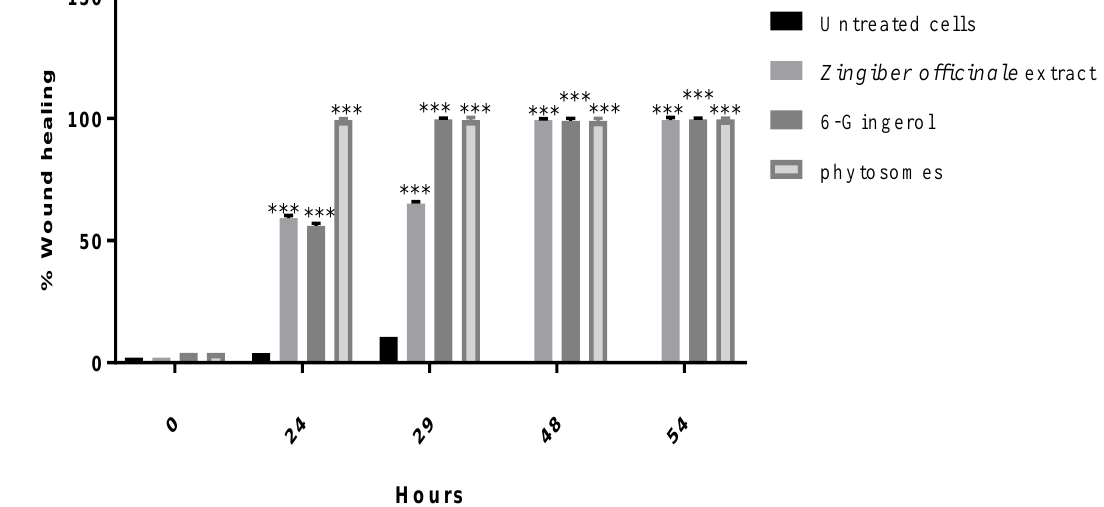
Figure 6. Effect of Zingiber officinale extract, 6-gingerol, and 6-gingerol-loaded PEGylated nanophy- tosomes on wound healing of human periodontal ligament fibroblasts cells compared with control (untreated cells). ***: p < 0.001.